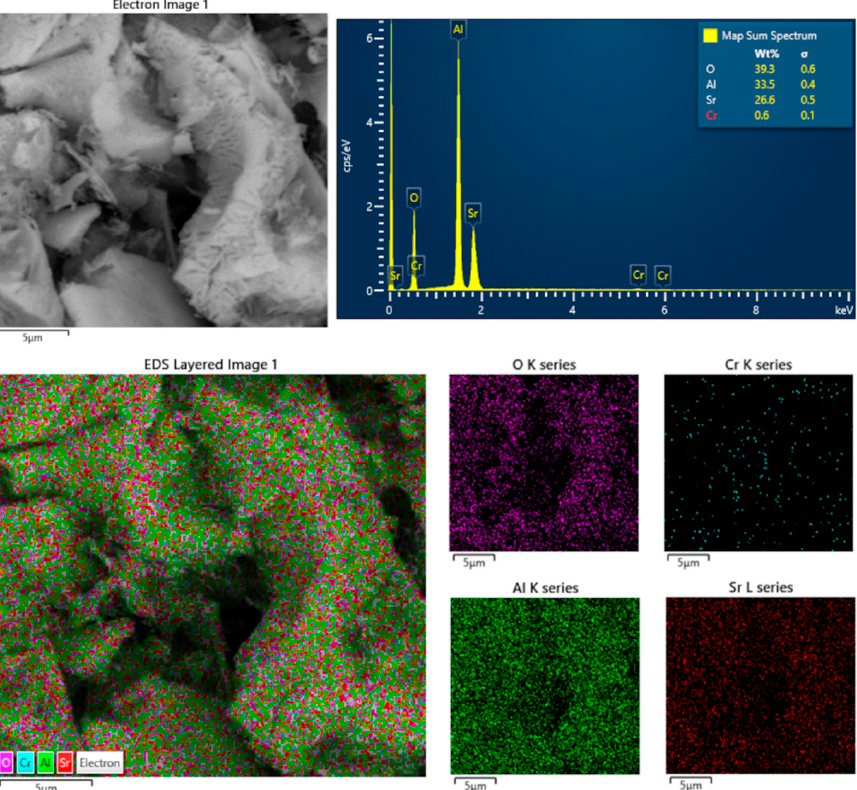
Figure 4. SEM images, results of local X-ray spectral analysis and elements distribution in the SrAl 4 O 7 :0.05Cr powder heat-treated at 1200 °C.